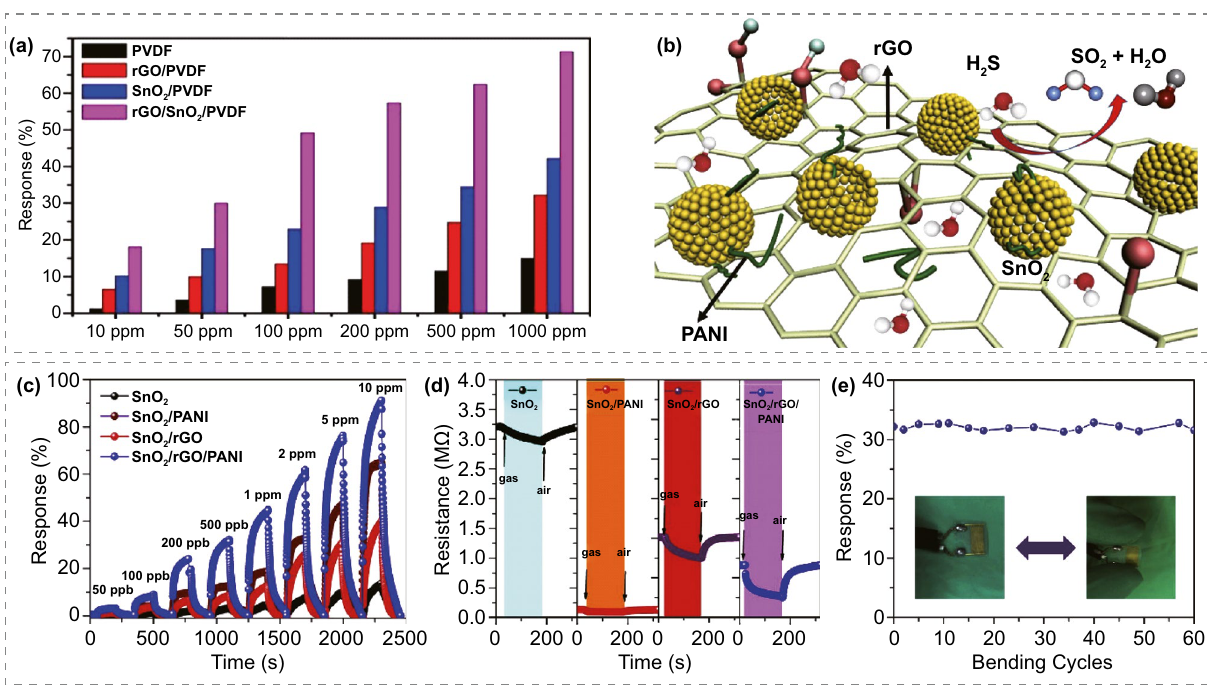
Fig. 8 a Response comparison among the pristine PVDF, RGO/PVDF, SnO 2 /PVDF, and RGO/SnO 2 /PVDF composites. Reproduced with per‑ mission from Ref. [94]. Copyright (2020) Springer Nature. b The sensing mechanism diagram of SnO 2 /RGO/PANI nanocomposites towards H 2 S. c Response comparison among SnO 2 , SnO 2 /PANI, SnO 2 /rGO and SnO 2 /rGO/PANI. d Transient resistance of SnO 2 , SnO 2 /PANI, SnO 2 / RGO and SnO 2 /RGO/PANI towards 2 ppm H 2 S. e The response of SnO 2 /RGO/PANI hybrid to 500 ppb H 2 S after bending test. Reproduced with permission from Ref. [98]. Copyright (2019)